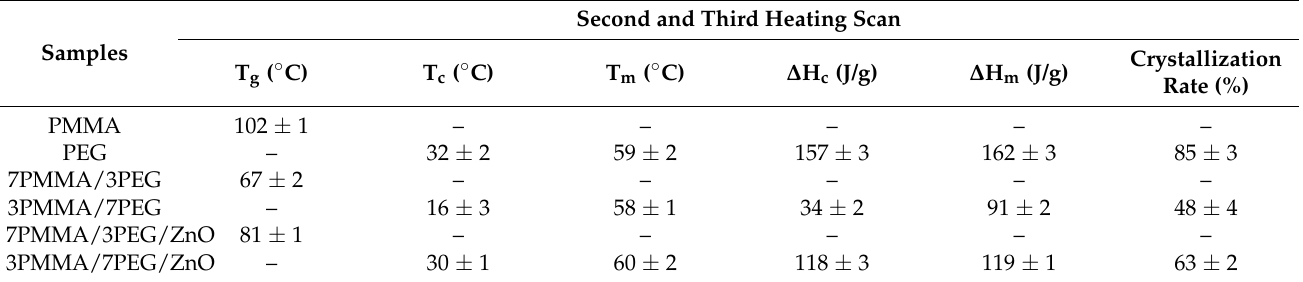
Table 3. DSC results of the neat polymers, polymer blends and nanocomposites.